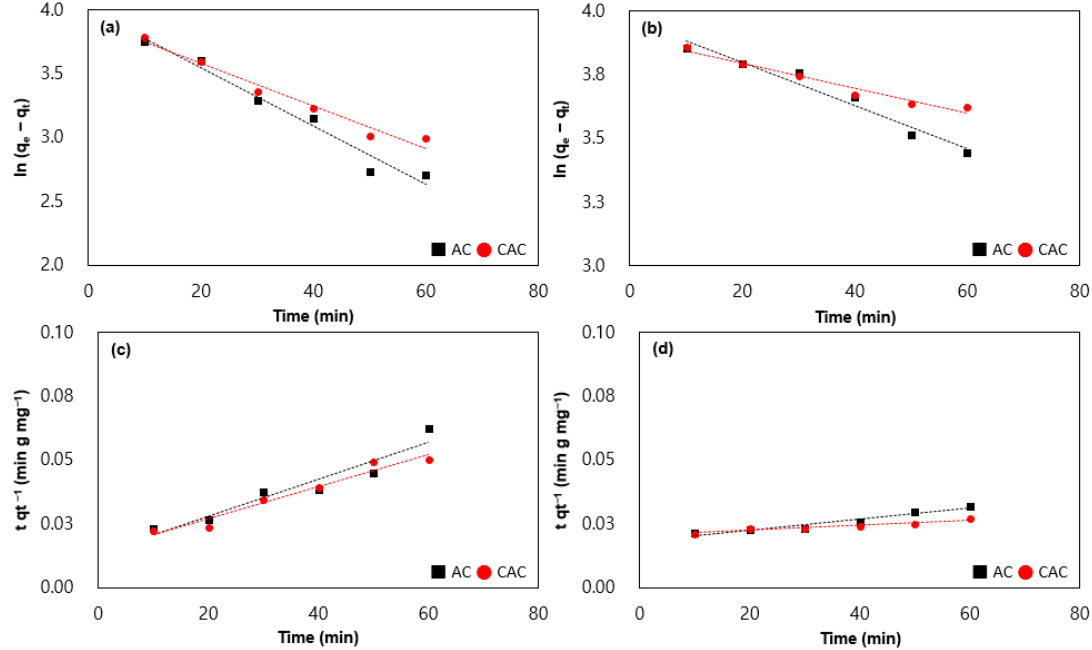
Figure 4. Pseudo- fi rst-order kinetics of samples are depicted in ( a ) toluene and ( b ) benzene, while pseudo-second-order of the former ( c , d ). Table 5. Pseudo- fi rst-order and pseudo-second-order kinetic parameters of